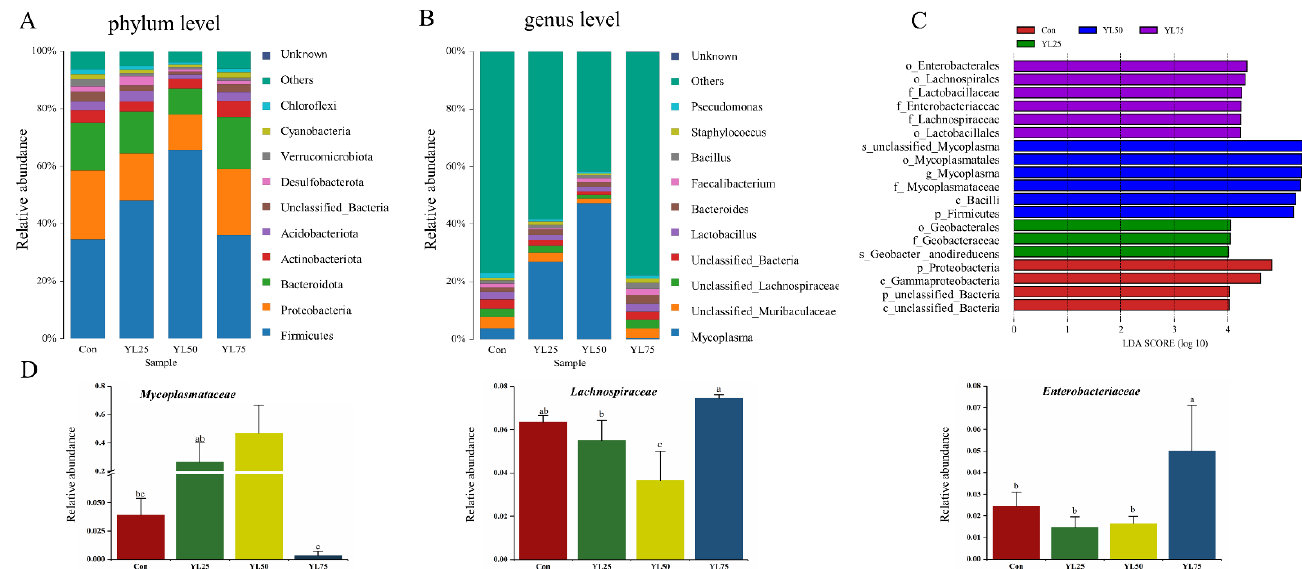
Figure 4. Difference analysis of intestinal microbiota between control and YL treatments of large- mouth bass. ( A ) The bar plots for the microbial community at the phylum level. ( B )The bar plots for the microbial community at the genus level. ( C ) The LDA scores of different microbes between the control YL treatments. Red means the control group; green means the YL25 treatment, blue means the YL50 treatment, purple means the YL75 treatment. ( D ) Comparison of the relative abundance of different microbes between the control and YL treatments. Values in rows with different superscript letters have significant differences ( p < 0.05). Con was the control diet. In the other three diets, 25%, 50%, 75% of the fish meal was replaced with YL. The diets were named YL25, YL50, and YL75, respectively.